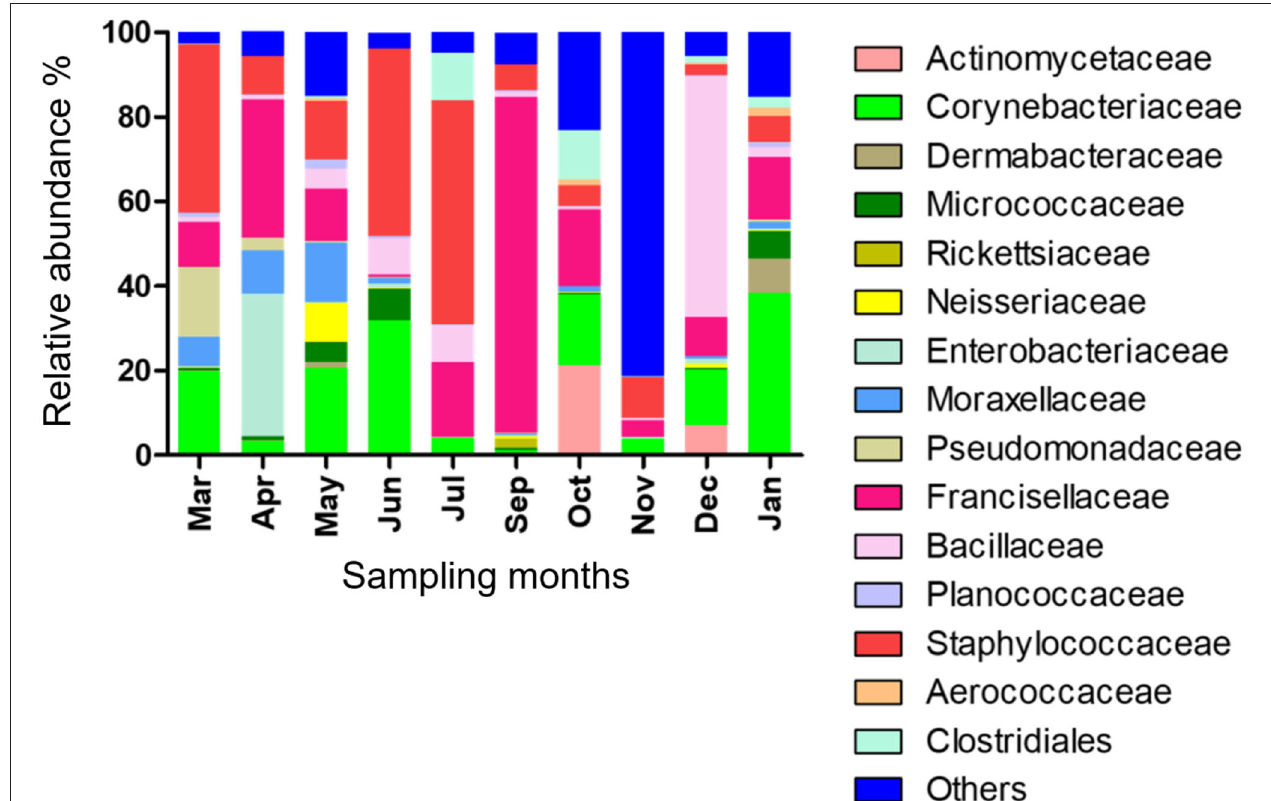
FIGURE 1 | Microbial families detected in H. dromedarii partially engorged female ticks from 10